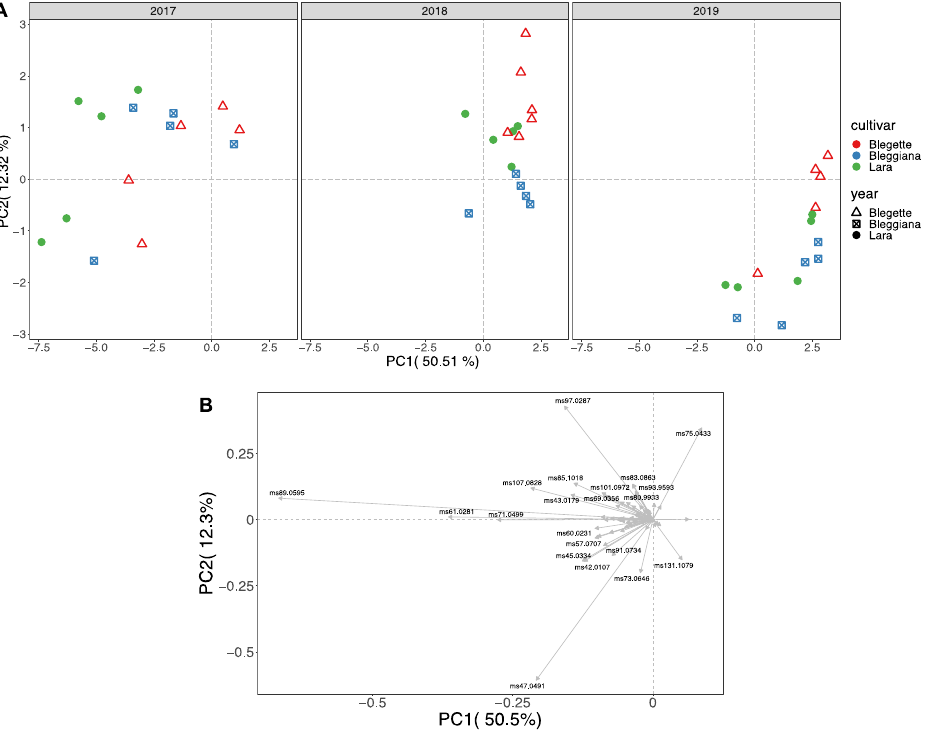
Figure 7. Principal component analysis (PCA) ( A ) and loading plot ( B ) of the VOC profiles, assessed by PTR-ToF-MS, of the walnut accessions ‘Bleggiana’, ‘Blegette’ and ‘Lara’ of three harvesting seasons (2017, 2018 and 2019). Each point of the PCA plot is the average of three technical replicates.